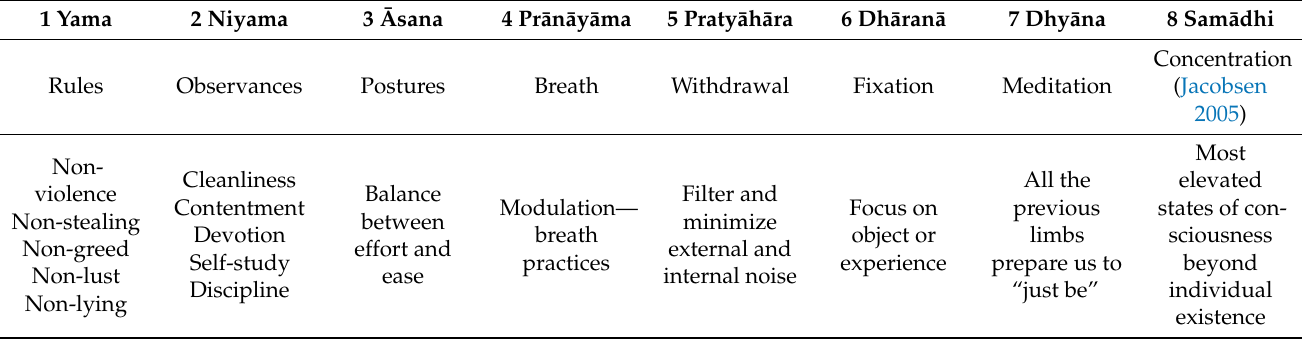
Table 1. 8 Limbs of Yoga (Mallinson and Singleton